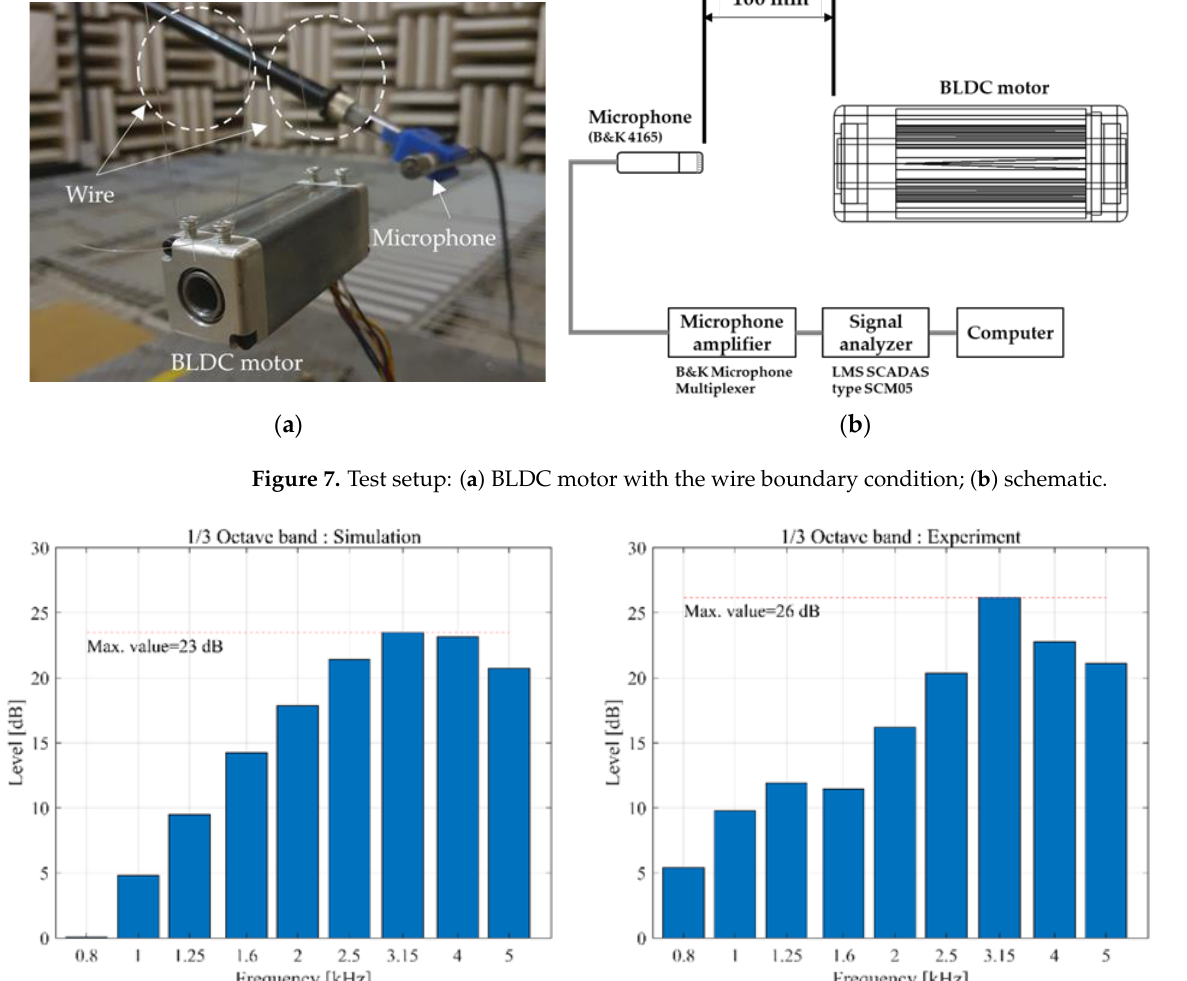
Figure 7. Test setup: ( a ) BLDC motor with the wire boundary condition; ( b ) schematic.